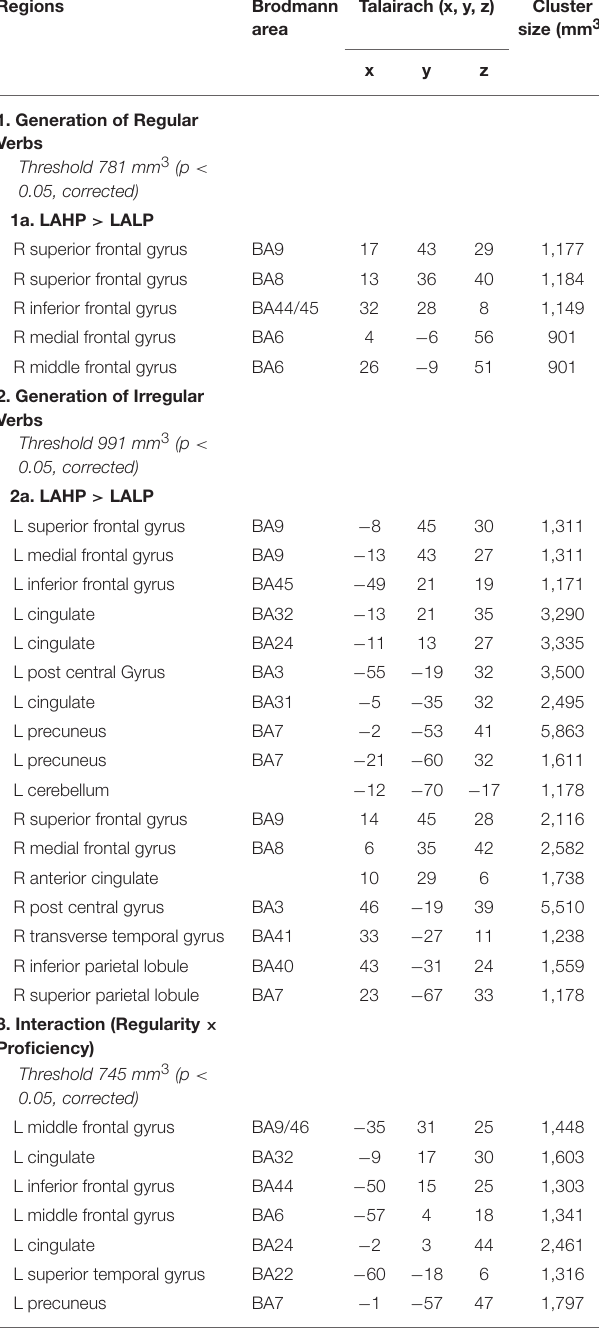
TABLE 4 | Regions activated by the LAHP vs. LALP groups in the (1) Generate Regular Past Tense, (2) Generate Irregular Past Tense, and (3) Contrast between Irregular and Regular Tense generation tasks,